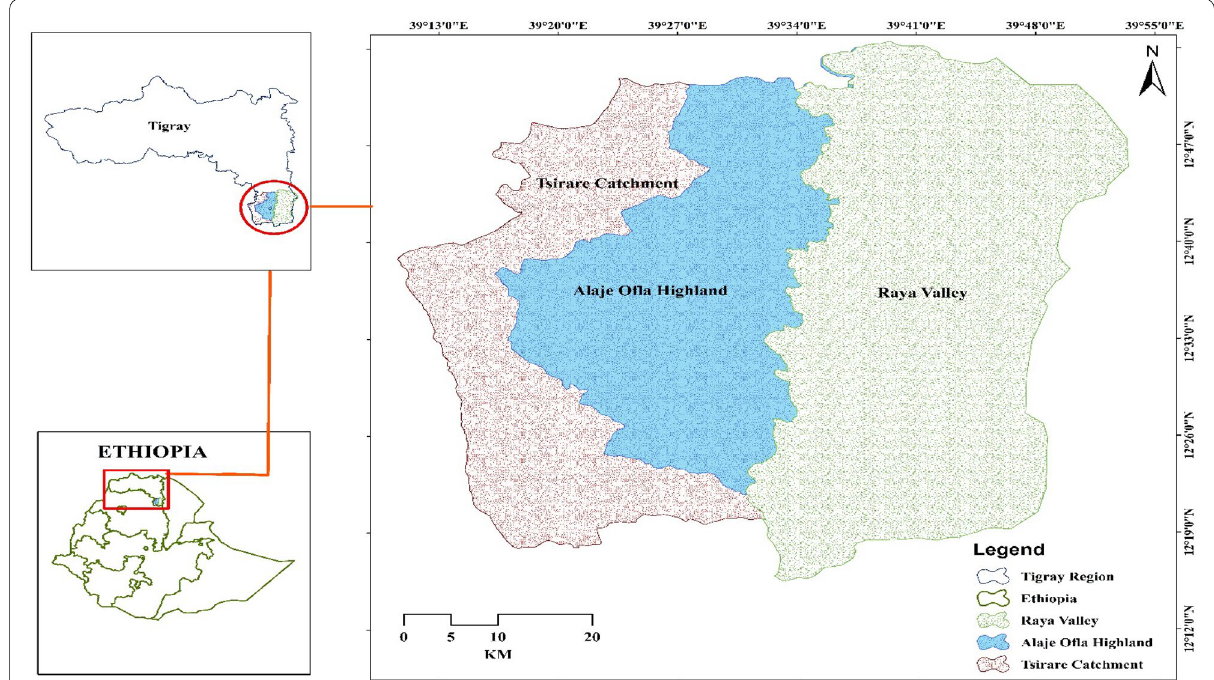
Fig. 1 The location of the study area (Source: FEWS NET